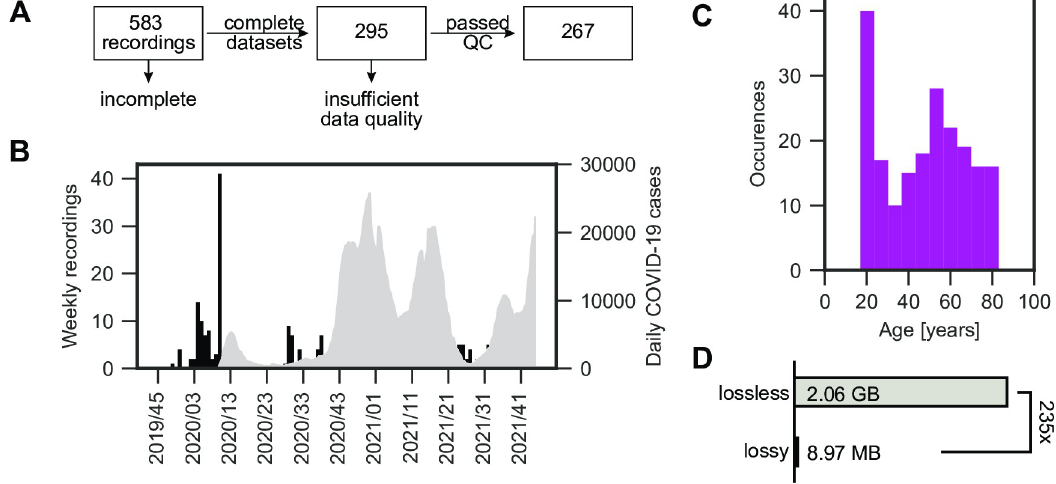
Fig 2. Acquired OpenHSV data overview. A: From initial 583 recordings, we excluded datasets that are missing any kind of data. From these, we excluded ones with insufficient data quality, such as occluded glottis. B: Frequency of recordings across the two year time frame is shown in black. Each bin corresponds to the recordings acquired in this week, denoted as year/calender week. The Germany COVID-19 cases are shown as a 7-day-average in gray. C: Age distribution across selected recordings from A. D: Comparison of file size between lossy and lossless